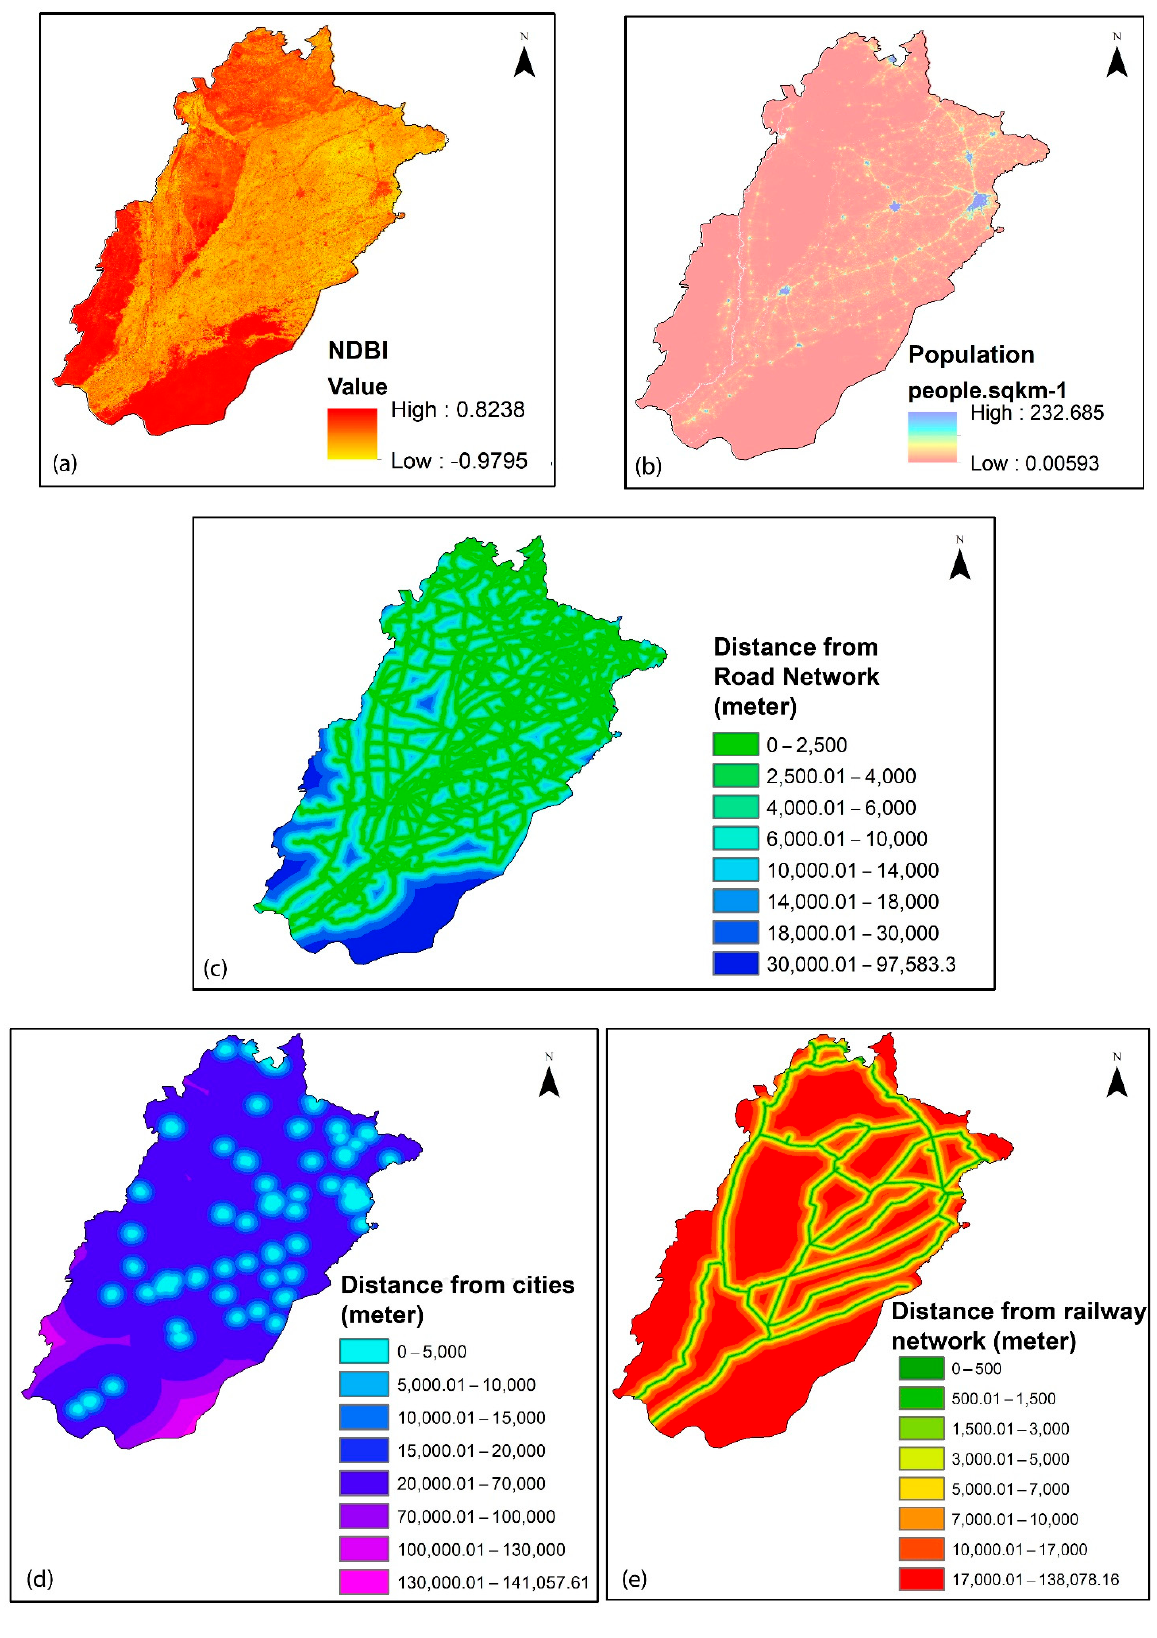
Figure A2. Maps of indicators belonging to socio-economics group (G2): ( a ) normalized difference built-up index; ( b ) population; ( c ) distance from road network; ( d ) distance from cities; ( e ) distance from the railway network.